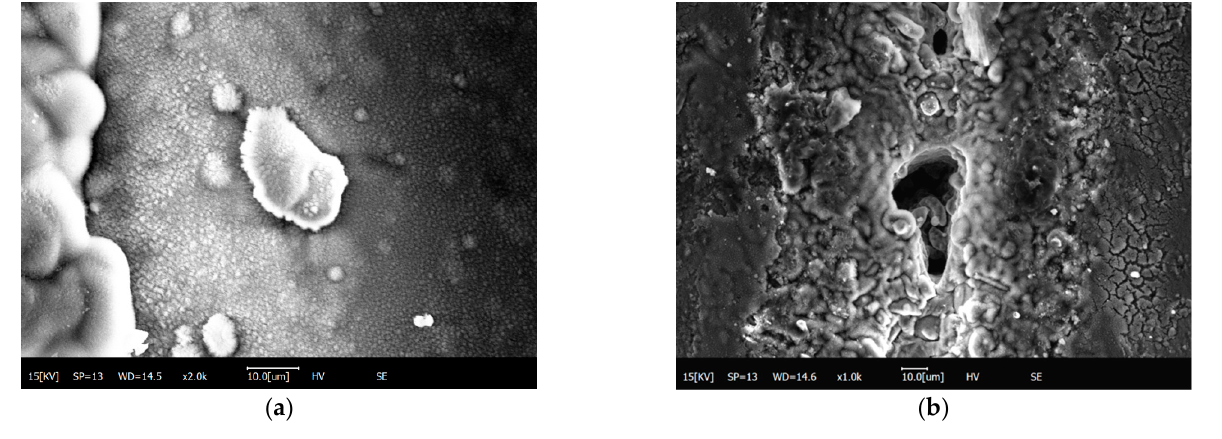
Figure 9. ( a ) Spatter of silicon carbide particles; ( b ) frequency hole.